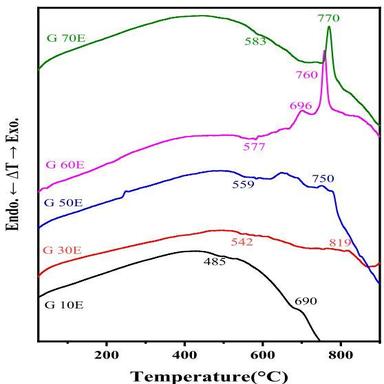
Differential thermal analysis of the investigated glasses.